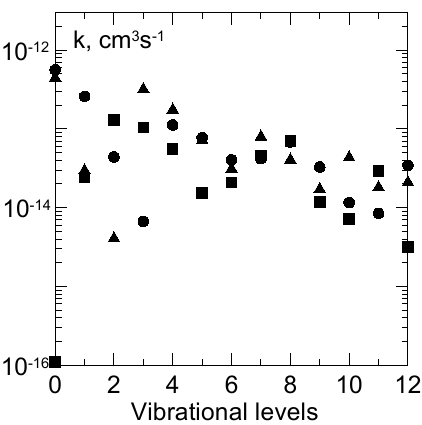
Fig. 5. The calculated rate coefficients of the excitation of the A 3 6 + u state in the process (4) for vibrational levels v=0, 2, 4 of Figure 5. The calculated rate coefficients of the excitation of the A 3 Σ u+ state in the process (4) the A 3 6 + u state – squares, circles, triangles, for vibrational levels v=0, 2, 4 of the A 3 Σ u + state – squares, cicles, triangles, respectively.